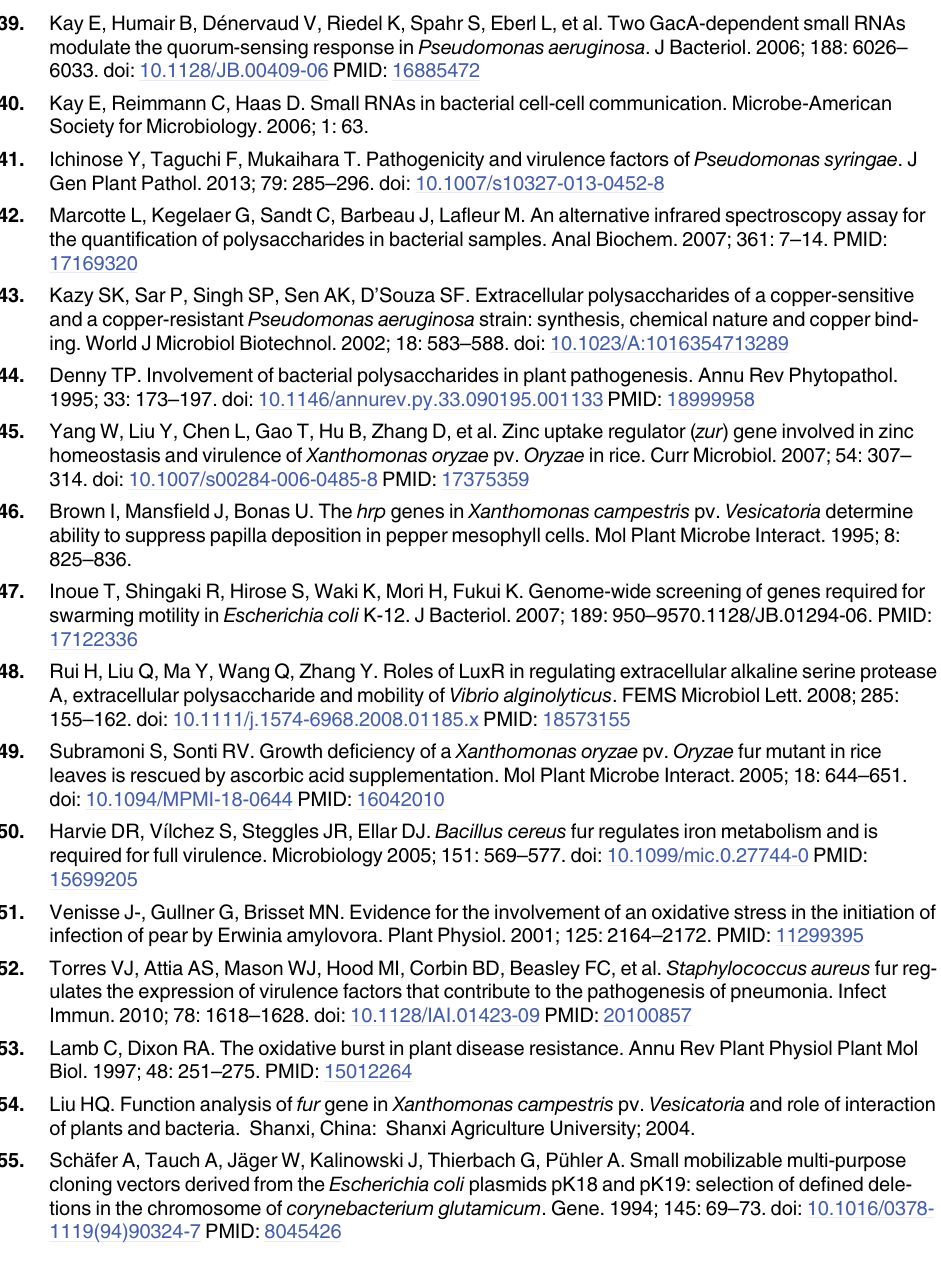
PLOS ONE | DOI:10.1371/journal.pone.0149280 February 24,